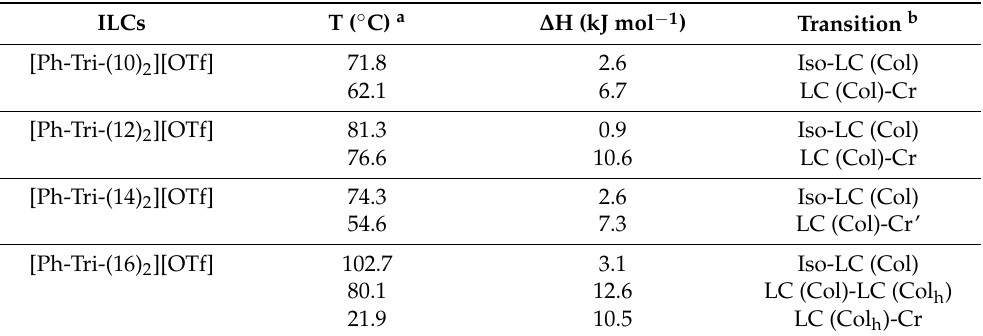
Table 2. Transition temperatures (T), enthalpies ( ∆ H) and phase transition of the salts obtained from DSC traces upon